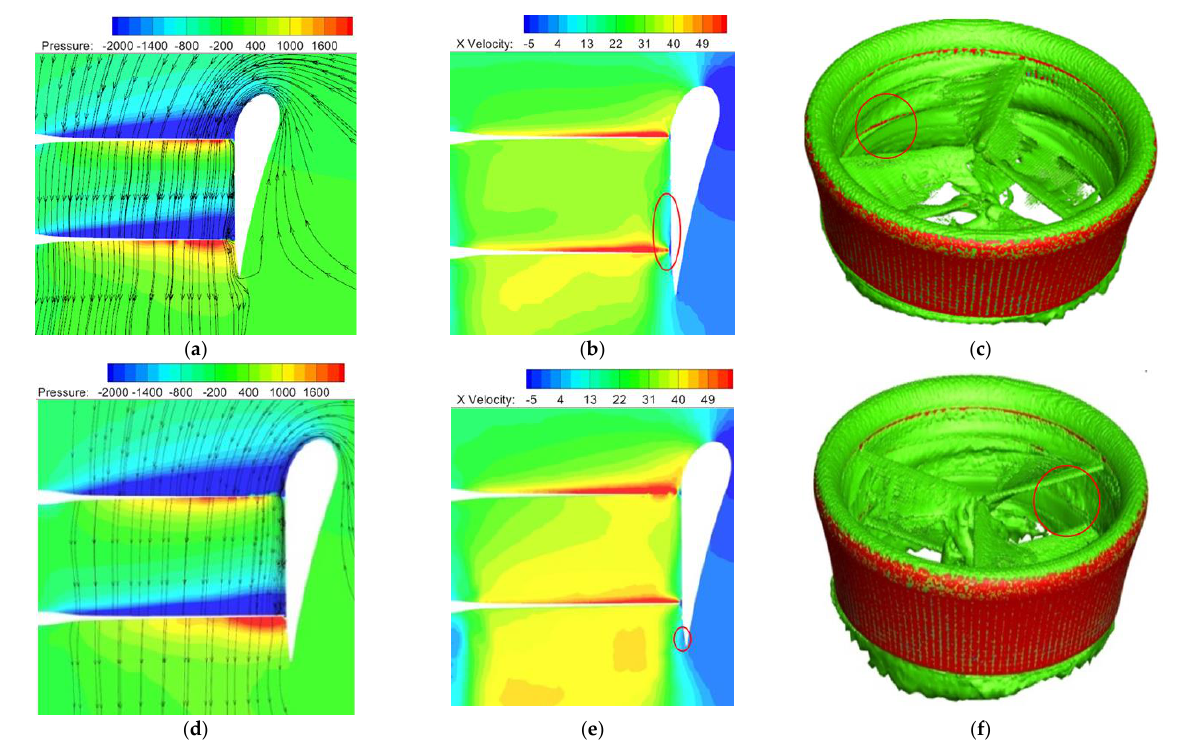
Figure 15. Flow field after adding VRR: ( a ) streamline diagram and pressure field (straight section); ( b ) axial induced velocity field (straight section); ( c ) vorticity diagram (straight section); ( d ) streamline diagram and pressure field (diffusion section); ( e ) axial induced velocity field (diffusion section); ( f ) vorticity diagram (diffusion section).